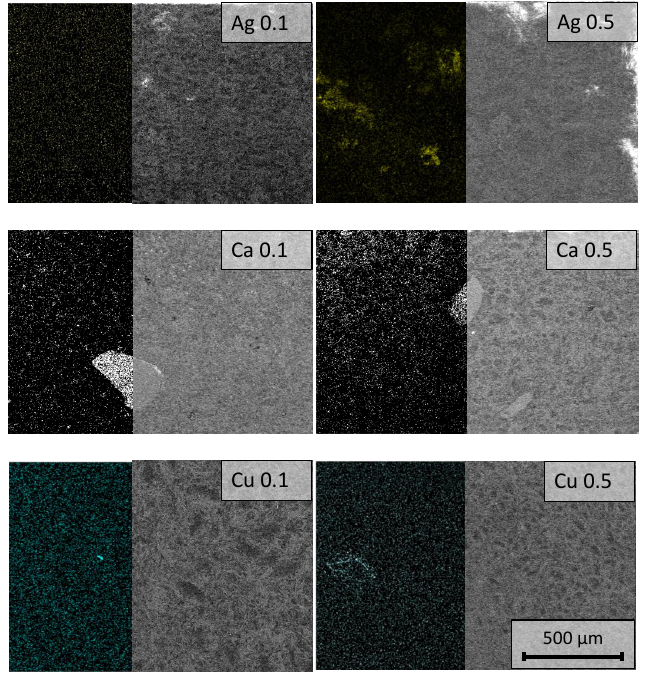
Figure 5. Image from electron microscope, BSE detector, magnified 200 white – calcium and blue –